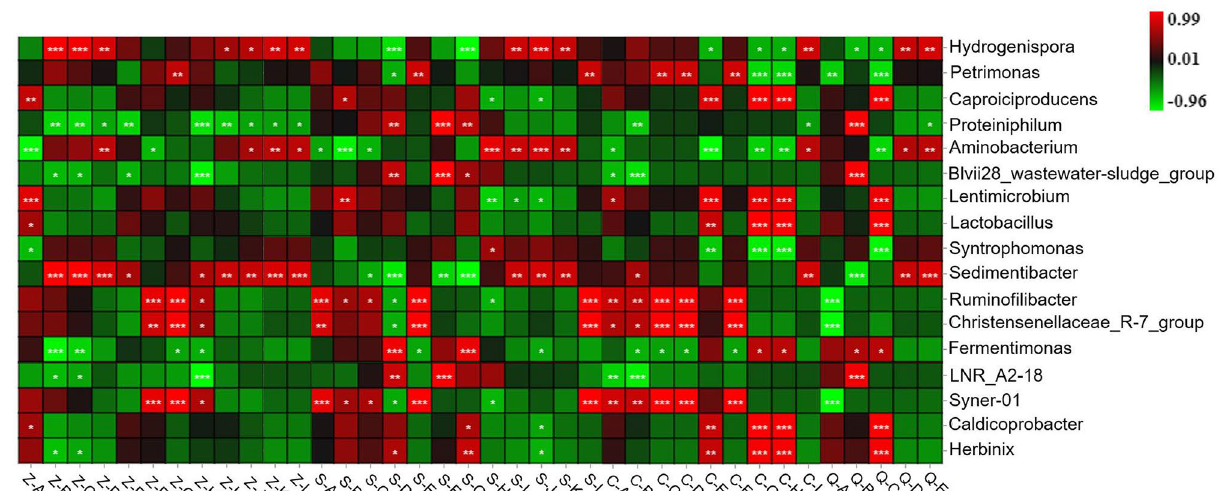
Figure 6. Heatmap showing the correlation between bacteria and the main volatile compounds in pit